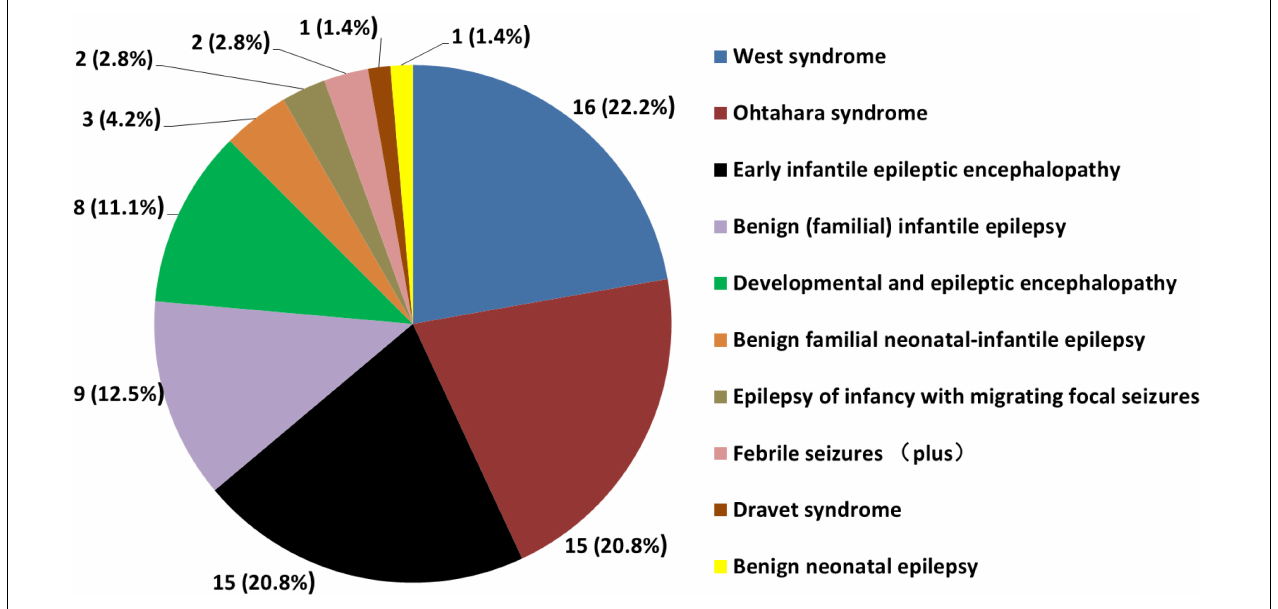
FIGURE 3 | Distribution of 72 Chinese epilepsy patients with SCN2A variants according to phenotypes [ n (%)].